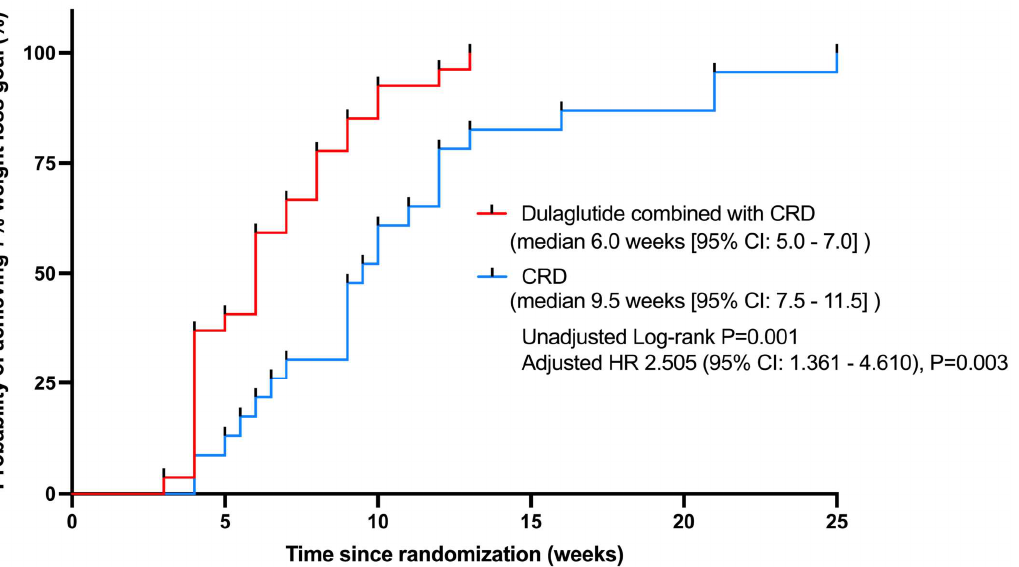
Figure 2. Time-to-event analysis of achieving 7% weight loss of initial body weight in the two groups. CRD, calorie-restricted diet; HR, hazard ratio.